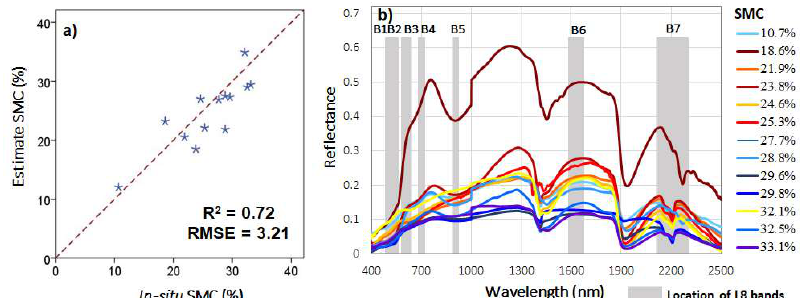
Figure 6. ( a ) Scatterplot showing the validated result of L8R SM for estimating SMC, using SMC estimated from R rs ( λ ) corresponding to L8 B5/B7, and the in situ SMCs of 13 soil samples taken in Nam Can Commune; ( b ) the features of R rs ( λ ) for these 13 soil samples. The error of L8R SM (RMSE = 3.21) corresponds to approximately 12% of the mean of the in situ SMC.